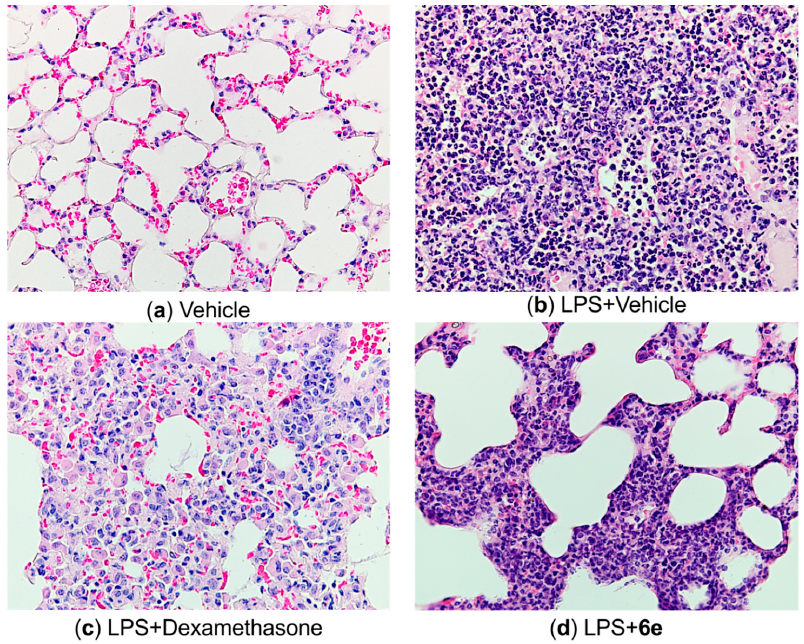
Figure 6. Lung sections. H&E staining, magnification ×400. ( a ) Intact control; ( b ) LPS-control; ( c ) LPS + 5 mg/kg dexamethasone; ( d ) LPS + 30 mg/kg 6e .